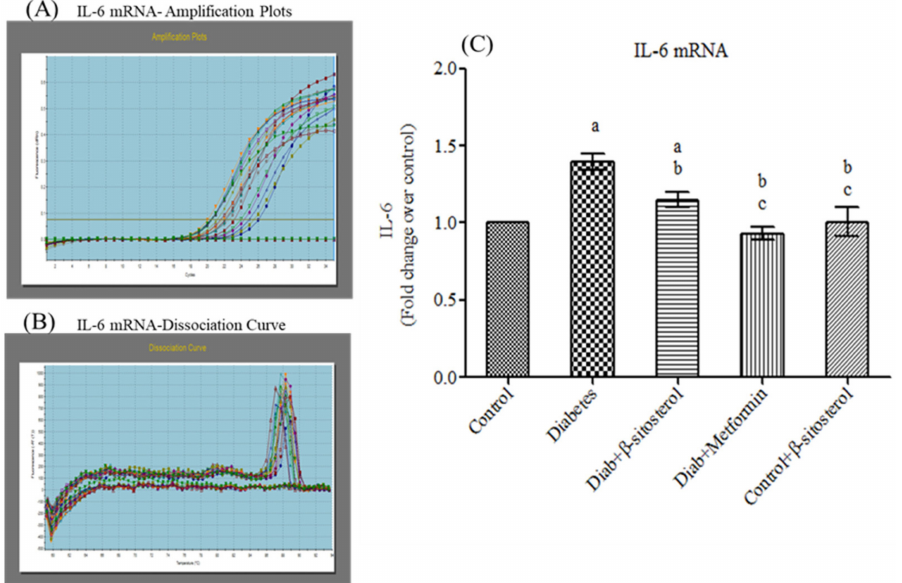
Figure 4. Effect of SIT on mRNA expression of IL-6 in adipose tissue of type-2 diabetic rats. IL-6 mRNA expression was assessed by real time-PCR. ( A ): Amplification plots; ( B ): dissociation curve analysis confirms the single product of IL-6 mRNA and ( C ): mRNA expression is given in fold change. Each bar represents mean ± SEM ( n = 6). Significance at p < 0.05. a Significantly different from the control group; b significantly different from the diabetic group and c significantly different from the β -sitosterol treated diabetic